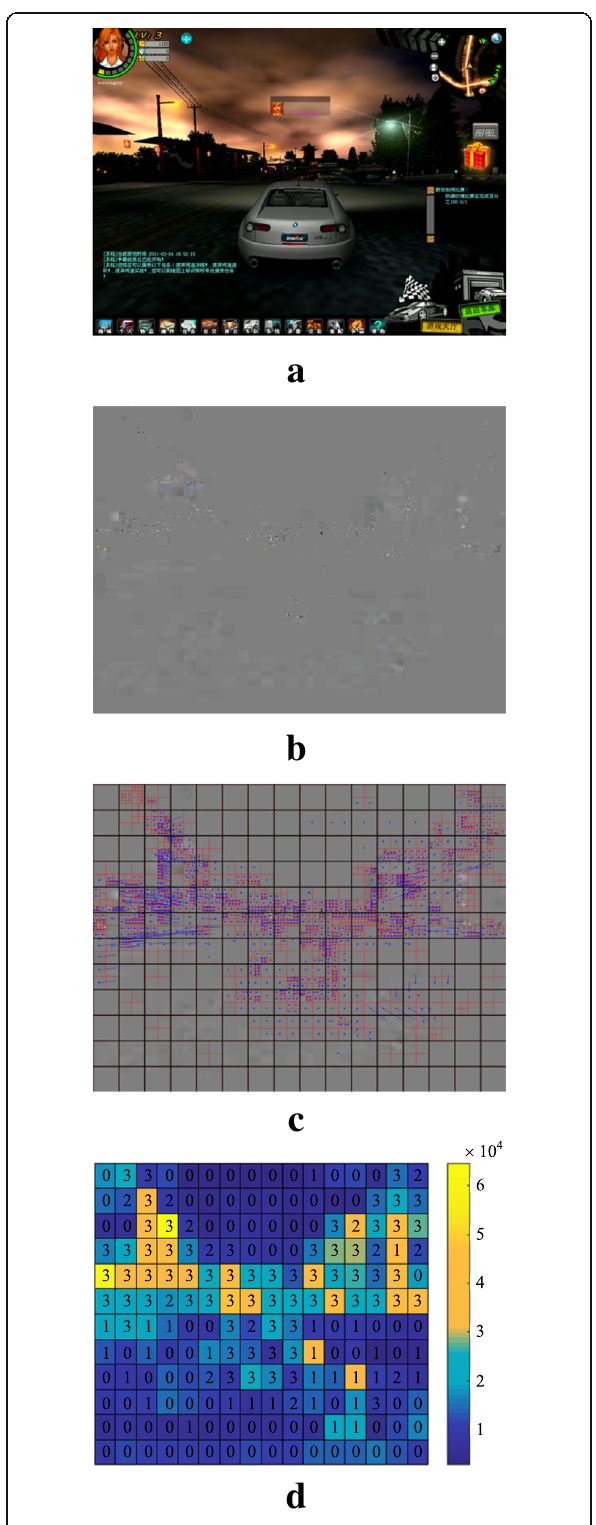
Fig. 5 Relation between CU partition and residual. a 16th frame in sequence ChinaSpeed . b Residual. c Optimal partition. d Relation between ESAD and optimal